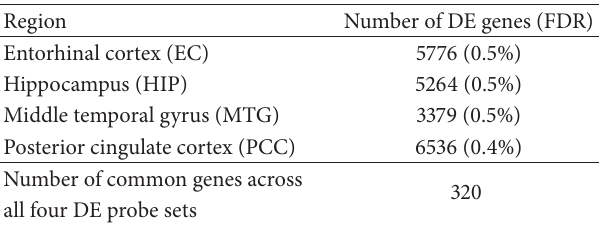
Table 1: Number of differentially expressed (DE) genes and associ- ated false discovery rate (FDR) in the four brain regions.